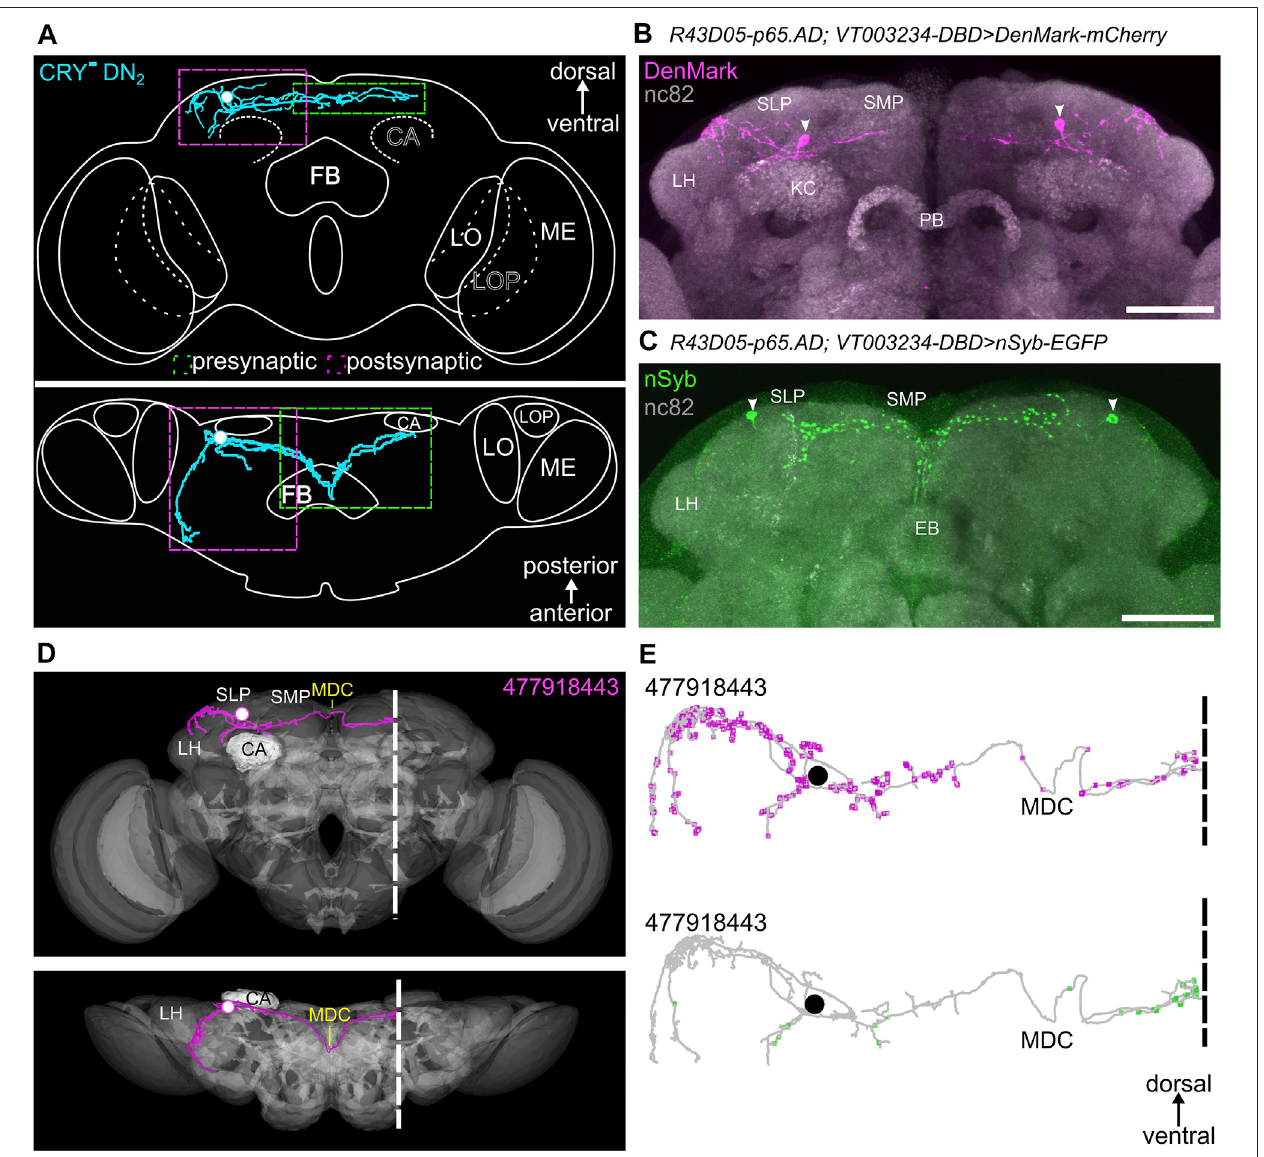
FIGURE 12 | Morphology of DN 2 #477918443 found in the hemibrain and its input and output sites. (A) Schematic summary of the morphology and the input (magenta) and output (green) sites of DN 2 #477918443. (B) Staining against mCherry the fl uorescent marker of DenMark which shows the dendritic sites of the DN 2 addressed by the split-GAL4 line. While the dendritic signal is strong in the arborizations branching in the superior lateral protocerebrum (SLP) and the fi bers running anterior at the border between the SLP and the lateral horn (LH), no or only weak signal could be recognized in the superior medial protocerebrum (SMP). (C) StainingagainstGFPtorevealtheaxonalendingsmarkedbytheenhanced GFP-(EGFP)tagged neuronalSynaptobrevin(nSyb).IncontrasttotheDenMarkstaining,the signalismostlyrestrictedtotheSMPandonlysomeornosignalcouldberecognizedinthelateralbrain. (D) ReconstructionofDN 2 #477918443onelectronmicroscopic level found in the hemibrain. The DN 2 shows only a few arborizations in the ipsilateral SMP but sends fi bers through the middle dorsal commissure (MDC) to the contralateral SMP. Additionally, fi bers are running and branching further on the ipsilateral border of SLP and LH anterior in the direction of the anterior optic tubercle (AOTU)without reaching it.Thewhitedashed lineshows theborder ofthe hemibrain. (E) Postsynaptic (magenta, input) and presynaptic (green, output) sitesofthe DN 2 . The input sites of the DN 2 are mainly restricted to the SLP as shown in the DenMark staining, while the output sites are largely absent since they are located in the contralateralSMP.ME,medulla;LO,lobula;LOP,lobulaplate;FB,fan-shapedbody;EB,ellipsoidbody;CA,mushroombodycalyx;PB,protocerebralbridge.Scalebars represent 50 μ m.